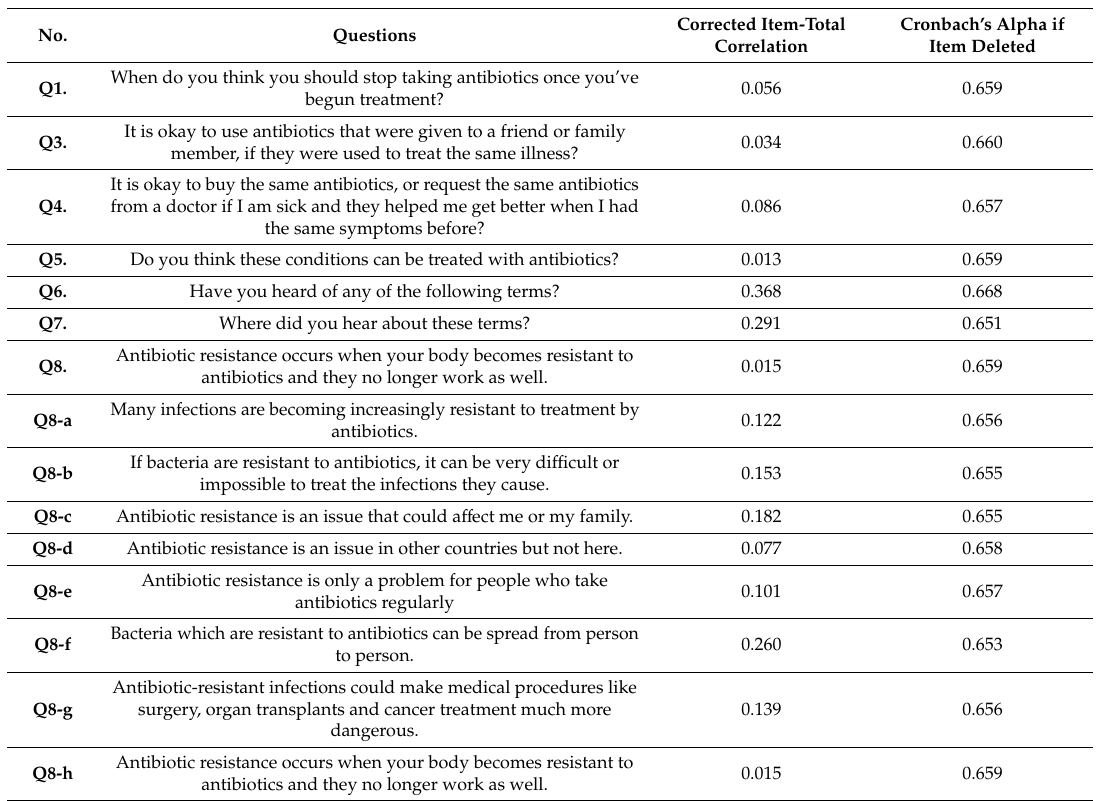
Table 5. Reliability test results for knowledge and understanding about antibiotic use and antibiotic resistance.